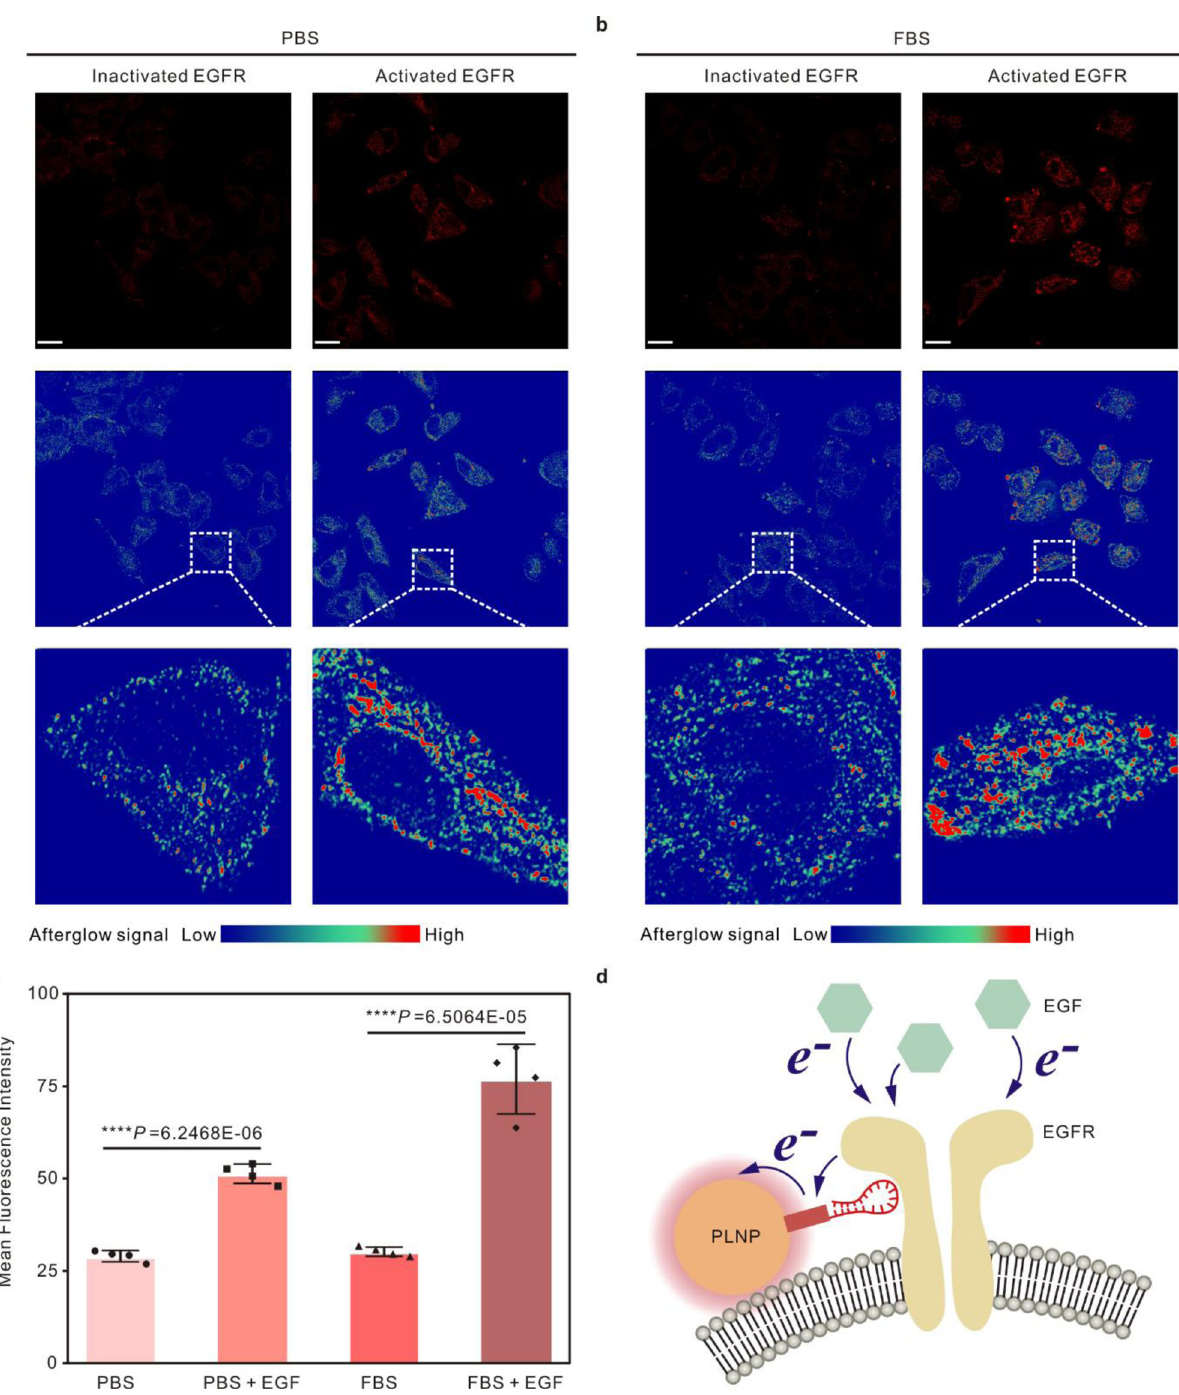
MDA-MB-231 cell, were tested with EGF stimulation and EGFR tyrosine kinase inhibition 51,52 (Supplementary Fig. 51). As a result, stimulation of EGF was found to activate the signals of ETTE probes signi fi cantly, while the afterglow signals in EGFR-expressing cells were completely blocked by co-application of afatinib, an EGFR